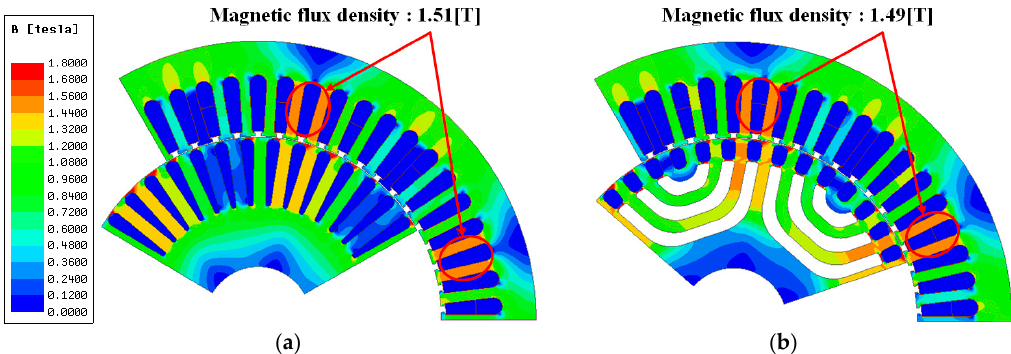
Figure 5. Electromagnetic analysis result of reference models: ( a ) IM, ( b ) LS-SynRM. Table 3. Characteristics of reference models using FEA.